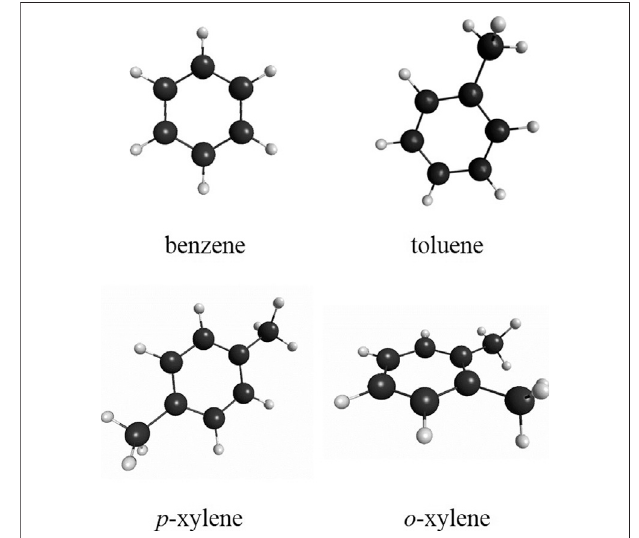
FIGURE 1 | Schematic showing the structure of the four small aromatic molecules, benzene, toluene, o -xylene and p